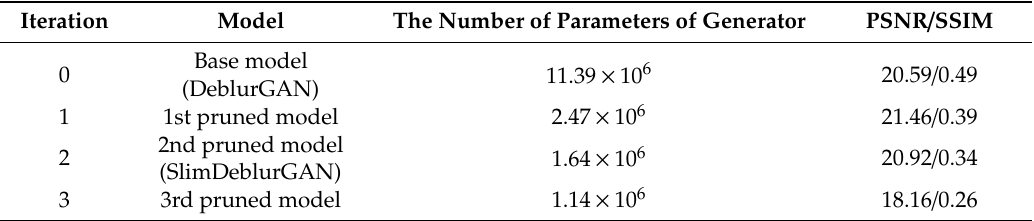
Table 6. DeblurGAN channel pruning iterations.